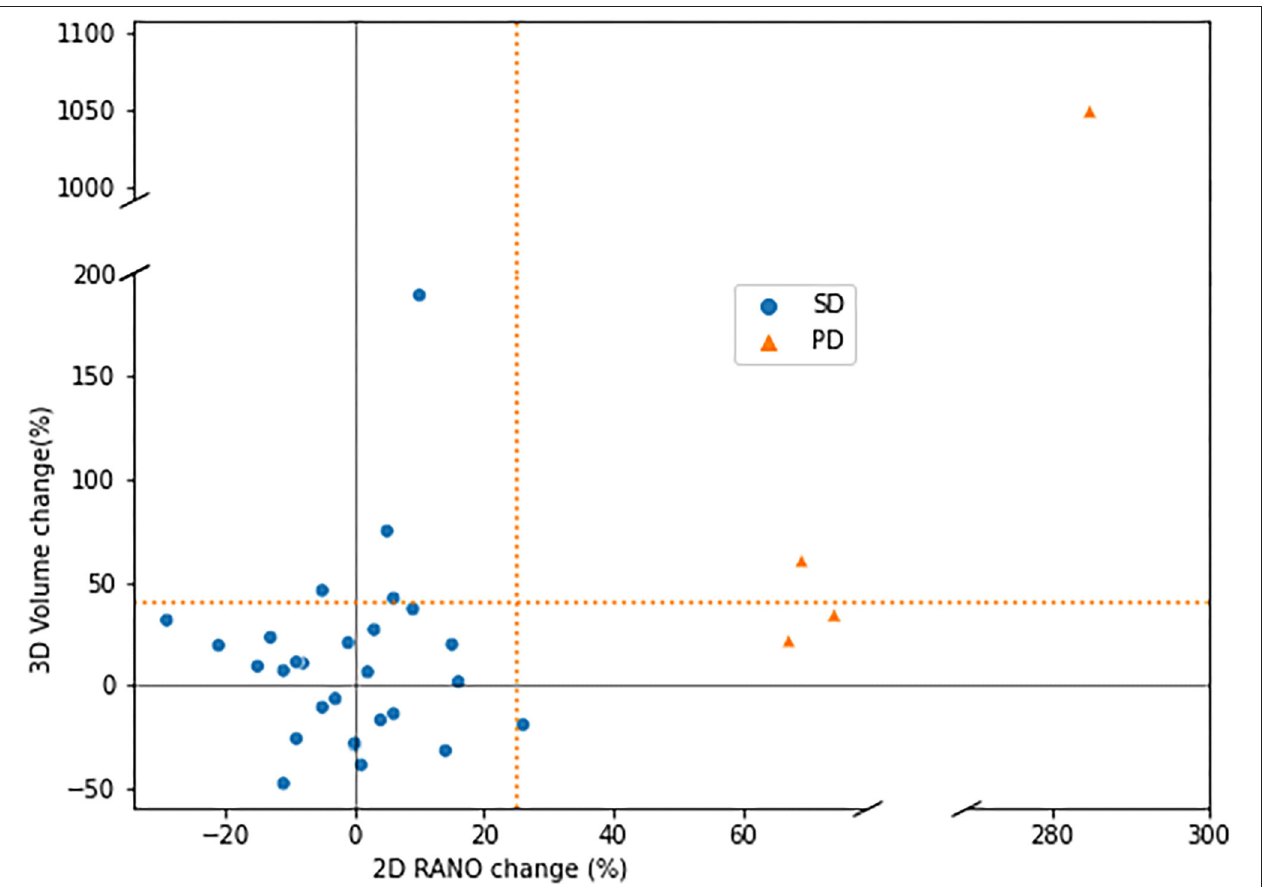
FIGURE 7 | Comparison of measurements using EASE (volume) and 2D RANO (product of two diameters), in percentage change with respect to the first ( t − 2) scan, for patients where both measurements were successful (33 patients). Dotted lines indicate the recommended thresholds for diagnosis of